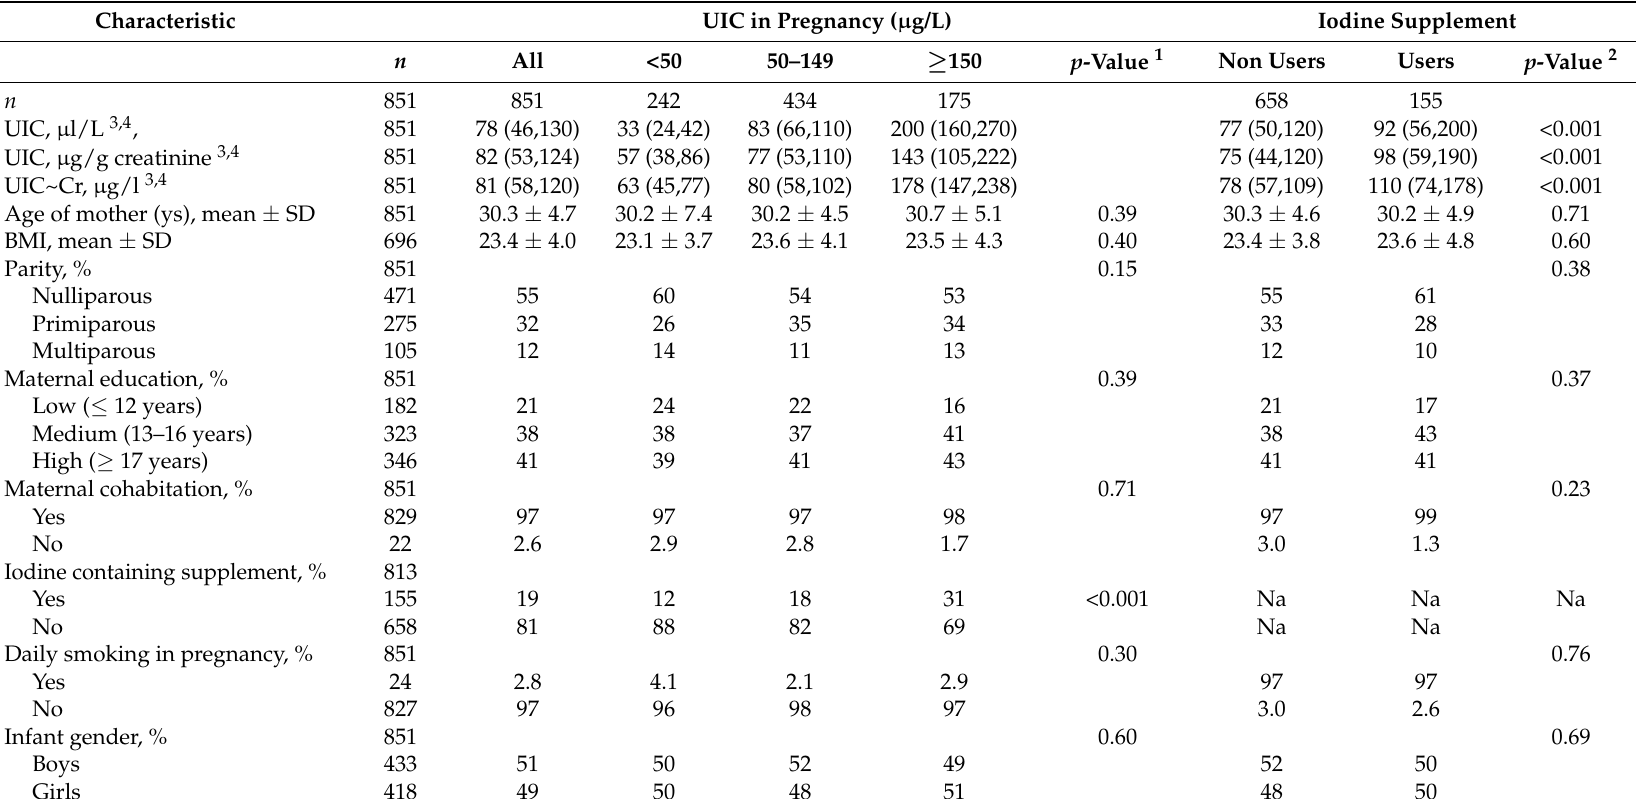
Table 1. Characteristics of the study population by UIC in pregnancy and by use of iodine-containing supplements.